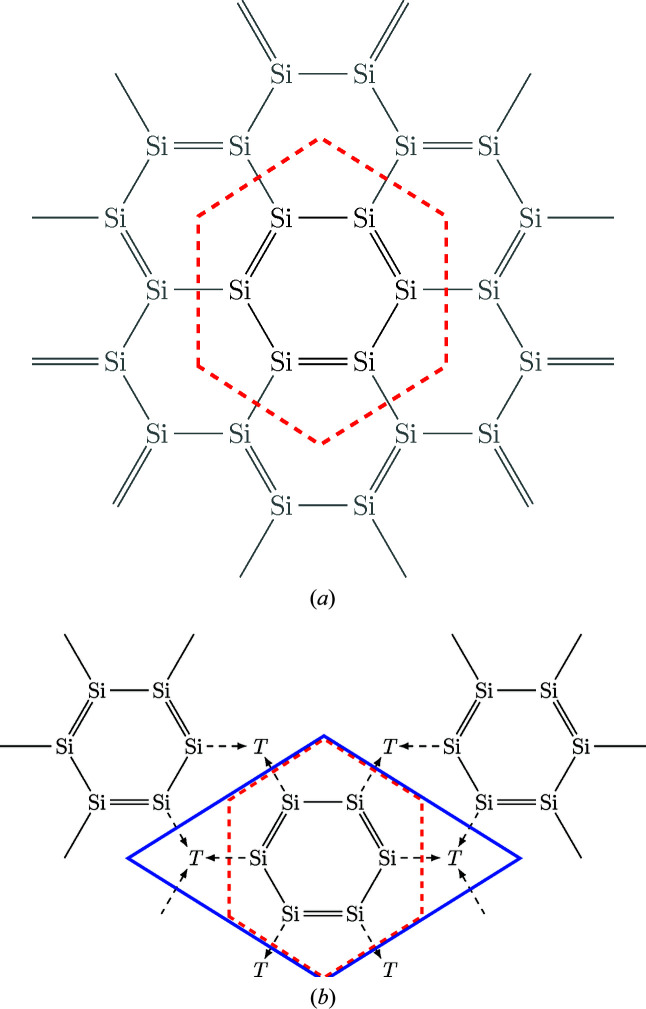
Snapshot of the distribution of delocalized single and double bonds in AlB2-like RSi2 and ordered R
2
TSi3 compounds. (a) RSi2 compounds and (b) ordered R
2
TSi3 compounds. These figures only include the Si/T sublayers. The unit cell of the minimal structure pattern of ordered R
2
TSi3 compounds is highlighted in blue and the isolated Si hexagon is highlighted in red. Dashed arrows indicate the coordinative bonds between Si and T atoms.